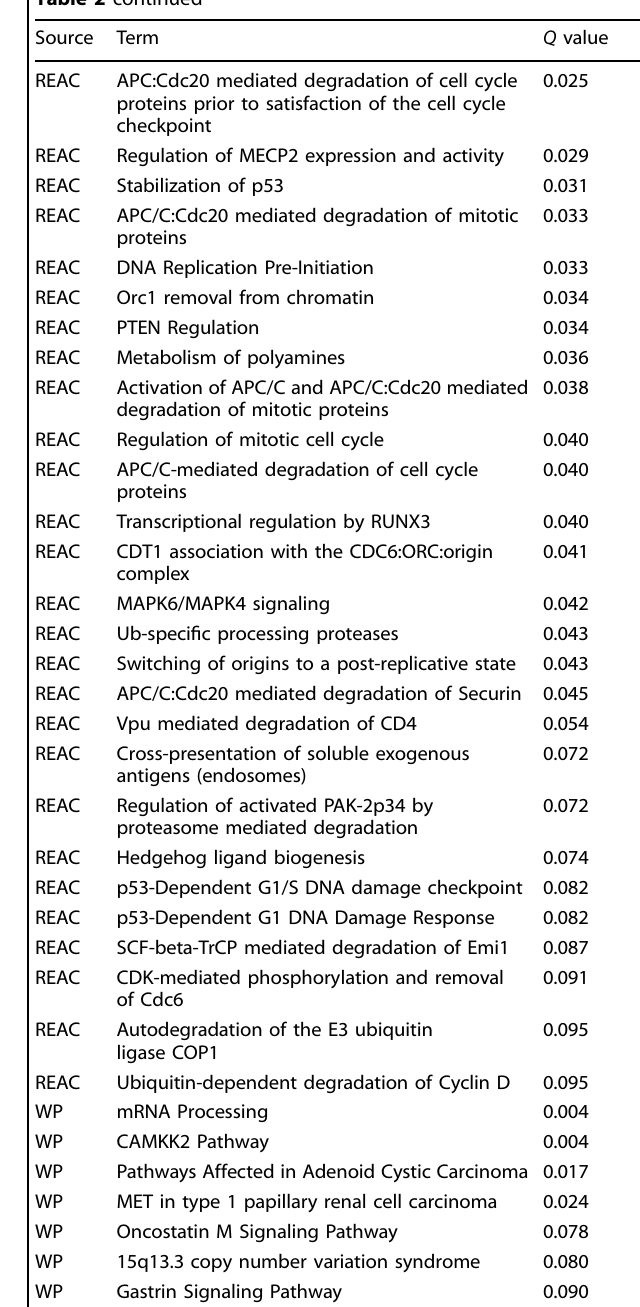
expression in astrocytes ( z -score = 2.74, q val = 0.047), much like the enrichment of ET genes in cerebellar astrocytes (Fig. 4a). In cortical tissue, convergent drug DEGs were mostly signi fi cantly enriched in non-neuronal cell types (Fig. 5d), notably oligodendrocytes ( z - score = 5.09, q val = 3.65E − 07), astrocytes ( z -score = 4.92, q val = 1.00E − 04) and endocytes ( z -score = 3.95, q val = 1.70E − 03). Unsurprisingly, given the use of propranolol to lower blood pressure, convergent propranolol DEGs were mostly enriched in endocytes ( z -score = 6.18, q val = 4.48 − 07) and vascular and leptomeningeal cells ( z -score = 4.77, q val = 1.52E − 04). Of note, propranolol DEGs